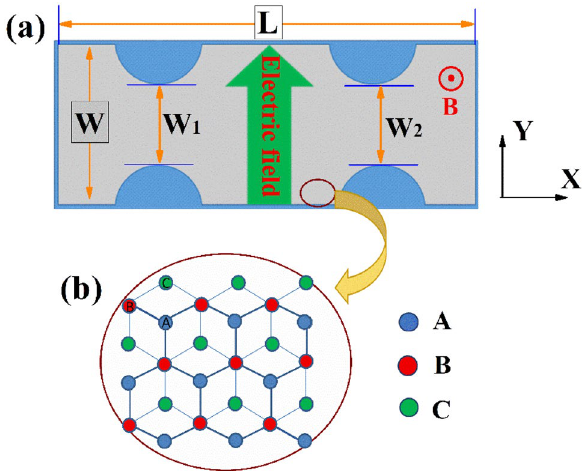
Figure 1. ( a ) Schematic diagram of the proposed device with two nanoscale constrictions, the distances between the two split gates on the left is indicated by W 1 and W 2 , the width W = 30 nm, the length L = 120 nm. The green arrow represents the direction of the electric field, and the magnetic field is applied perpendicularly to the plane. ( b ) The lattice structure of α -T 3 model. Three atoms in each unit cell are indicated by different colours, ie. A (blue), B atom (red) and C